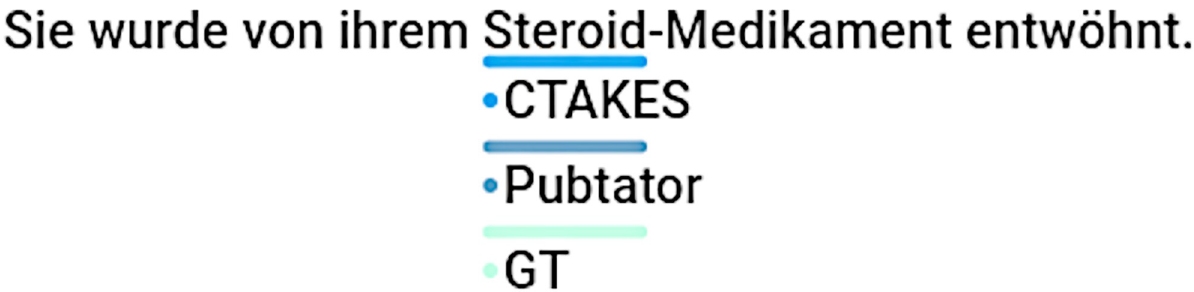
Fig 7. Comparative Sample 5. Ignored annotations due to WikiData graph structure ( Steroid as no subclass/instance of medication), DrNote).